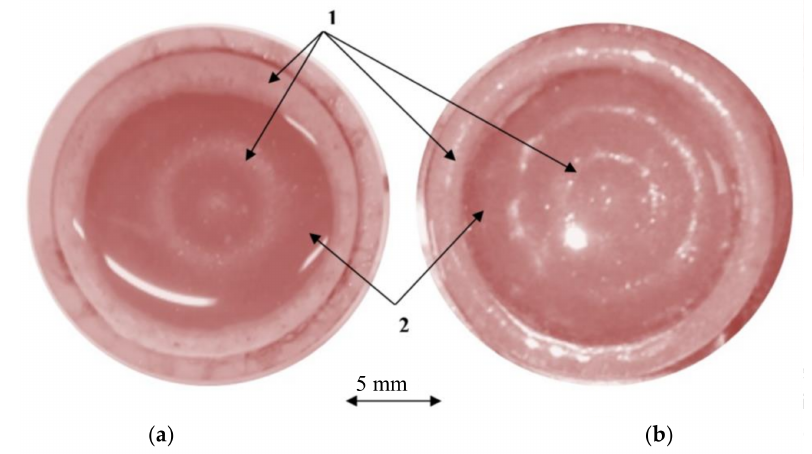
Figure 8. The distribution of the particles in the cylinder with the suspension under the influence of a standing ultrasonic wave: ( a ) excitation frequency of 202 kHz; ( b ) excitation frequency of 345 kHz; the microparticles distribution in standing wave nodal (1) and anti-nodal (2)